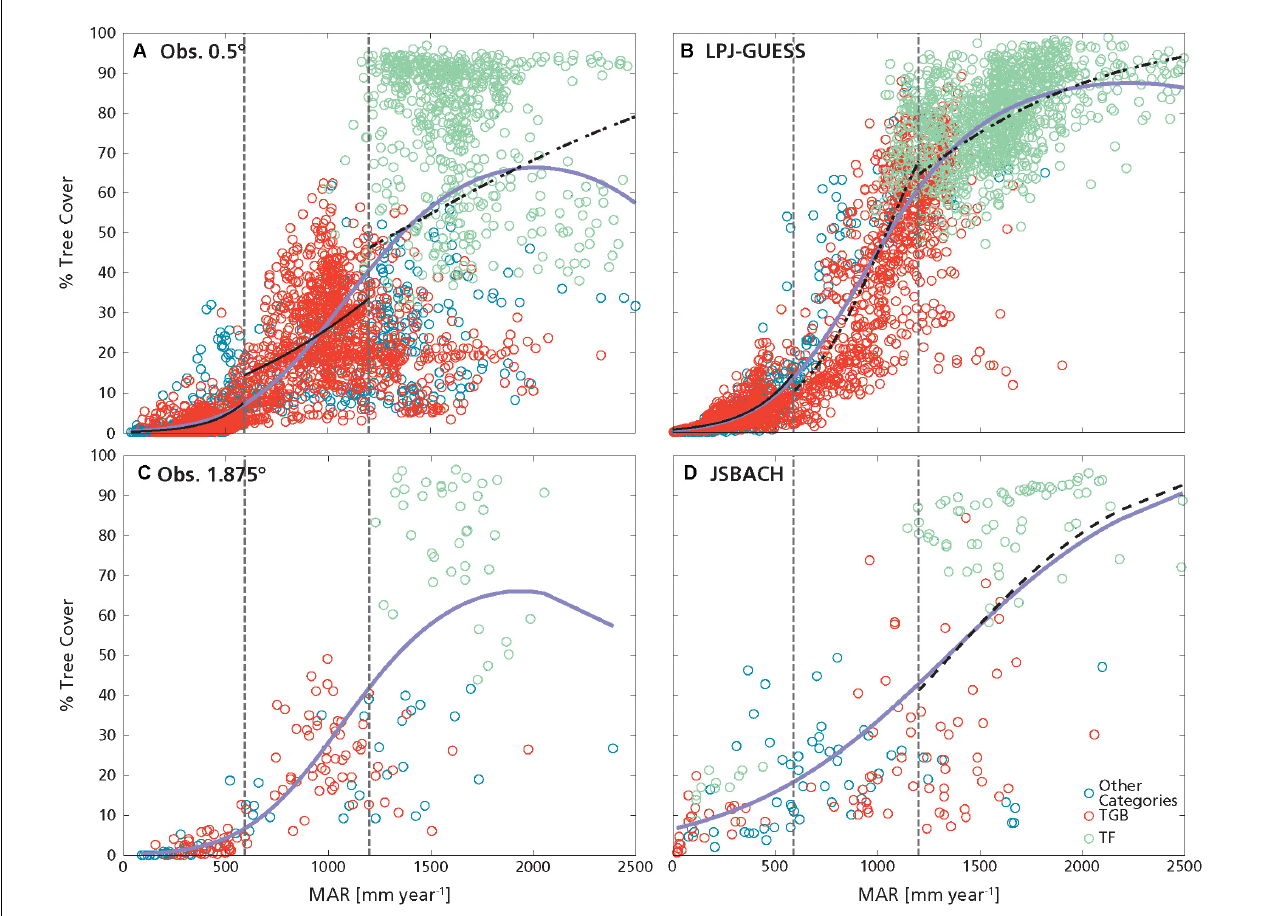
FIGURE 1 | Percentage tree cover as a function of mean annual rainfall (MAR): (A) obs. 0.5 ◦ , (B) LPJ GUESS, (C) obs. 1.875 ◦ , and (D) JSBACH. Dashed vertical lines delimit the ranges of low MAR (R1: MAR ≤ 590 mm year − 1 ), intermediate MAR (R2: 590 mm year − 1 < MAR < 1200 mm year − 1 ) and high MAR (R3: MAR ≥ 1200 mm year − 1 ). Black lines are the GLM fit of tree cover with MAR ( Table 2 and Supplementary Figures S6 – S8 ). Lilac lines represent the GLM fit performed over all data ( Table 1 ). Lines are continuous when the fits are the best GLMs explaining tree cover variation within the MAR range (i.e., with minimum AIC). If no fits are shown in a MAR range it means that there was no significant dependence of tree cover on MAR in that range. Green circles are grid cells with predominance of forest (TF), red circles with predominance of tropical grassy biome (TGB). Blue circles are grid cells with other or no predominant